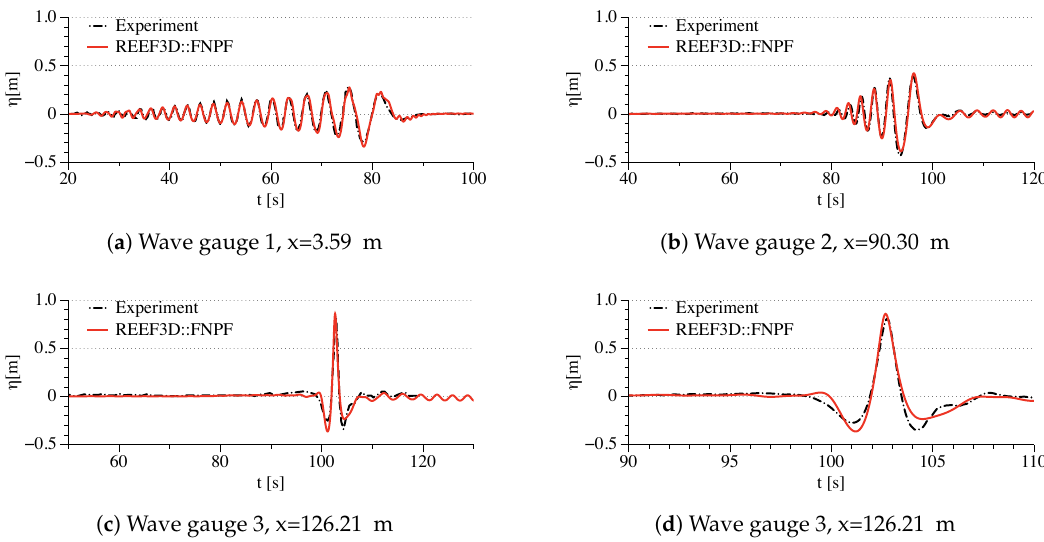
Figure 4. Comparison of the wave elevation time series at the three wave probes between the numerical wave tank and the experiment for the wave packet study. ( d .) The close-up view of the wave profile near the focusing region.